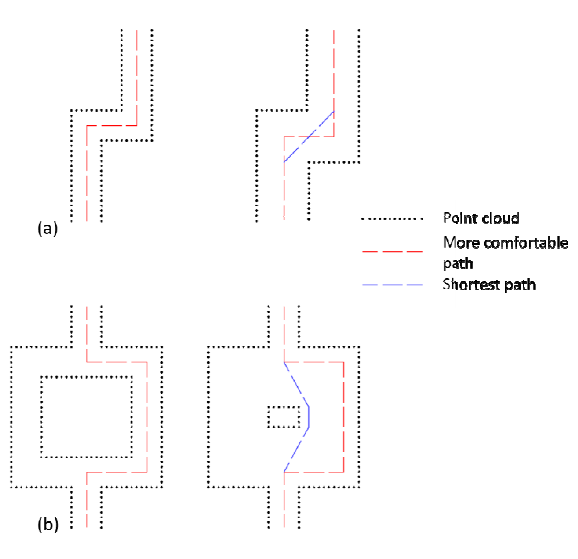
Figure 1. Example of indoor paths